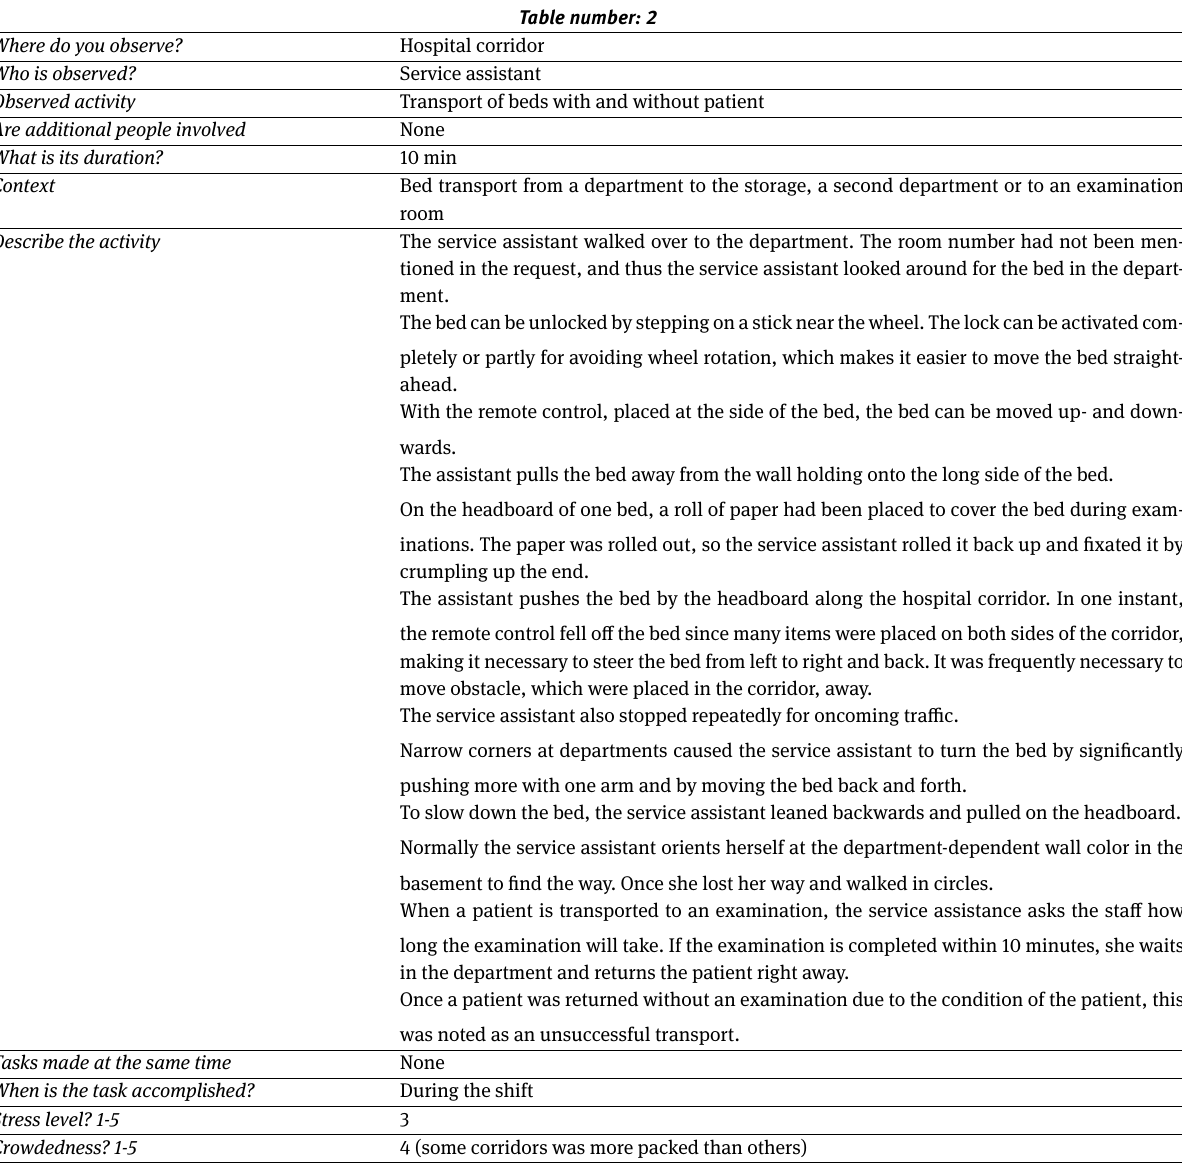
Table 3: Report number 12, table number 2 from evening observation at the Department of Cleaning and Hospital Service. The correspond- ing categorization of this process is provided in Figure 2. The frequency of 99 has be used to indicate that the observer could not specify the frequency of this workflow precisely but that the workflow is performed performed at least several times per